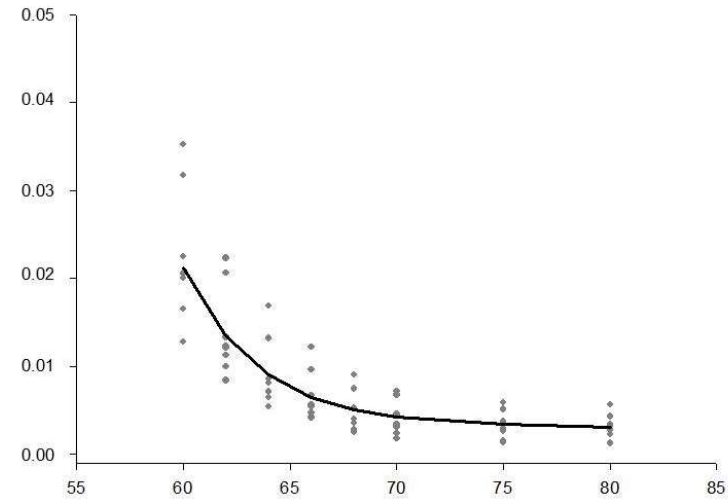
Figure 3. Best fit 2-compartment model for the plasma disappearance rate of indocyanine green in sham-operated animals as an example of how calculations were performed. This model allows for the estimation of the liver function in rats, but needs to be viewed with caution in hyperdynamic states.